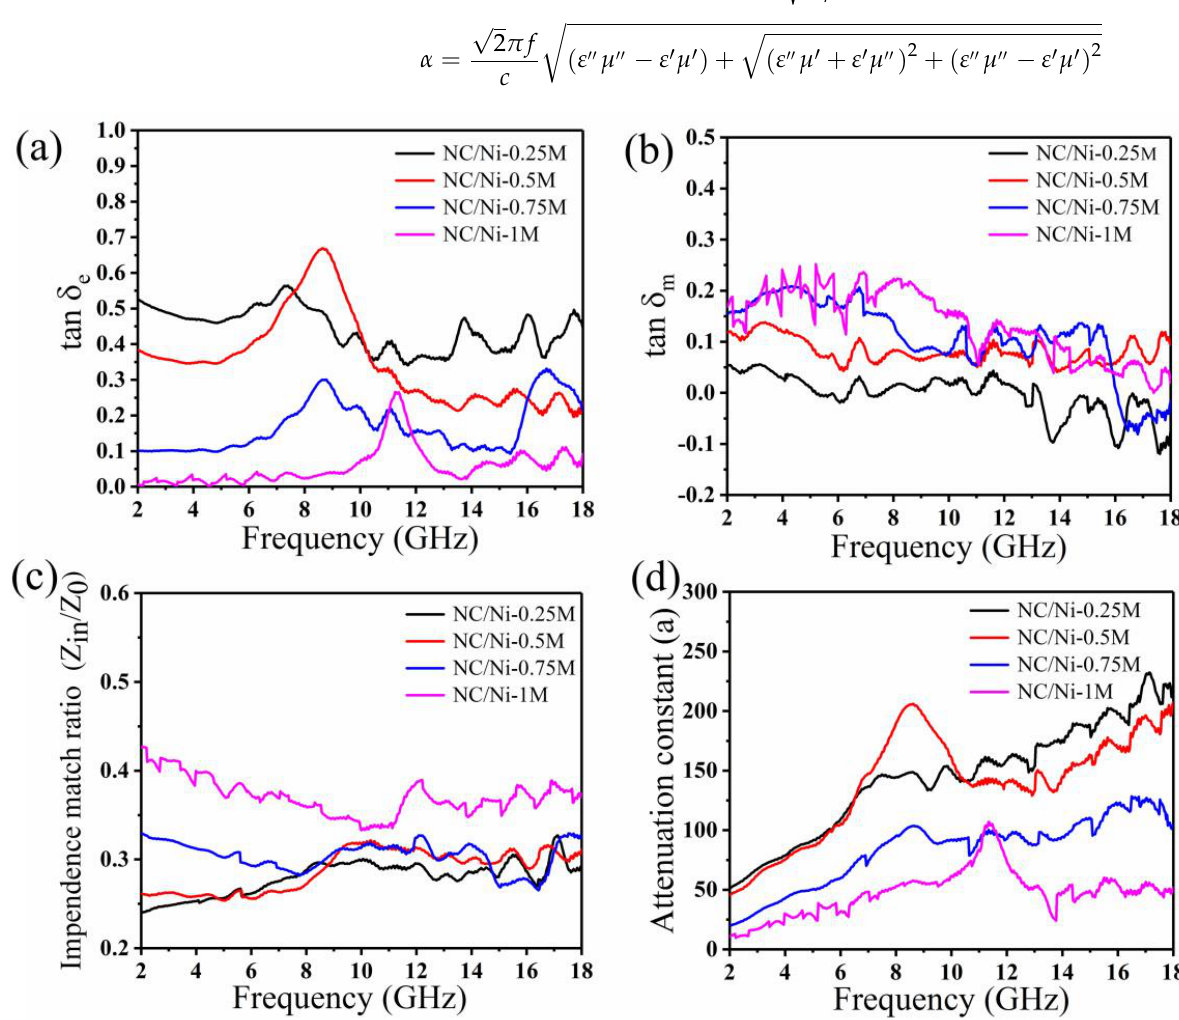
Figure 6. ( a ) The dielectric and ( b ) magnetic loss factors; ( c ) The radio of impedance matching and ( d ) attenuation constant of the complex of paraffin wax and NC/Ni with the loading of 50%.